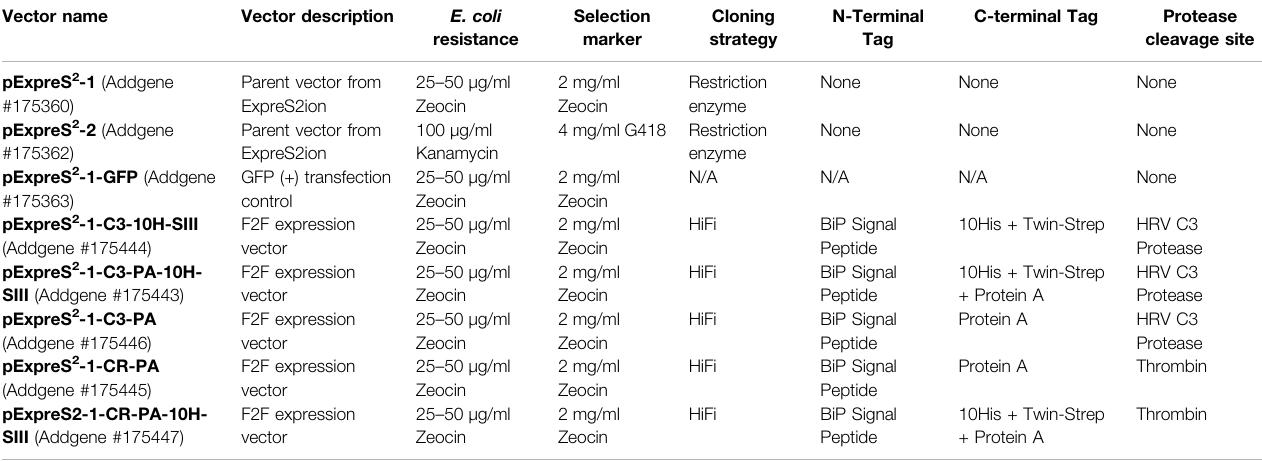
TABLE 1 | Overview of all the vectors used in this study and publicly available at